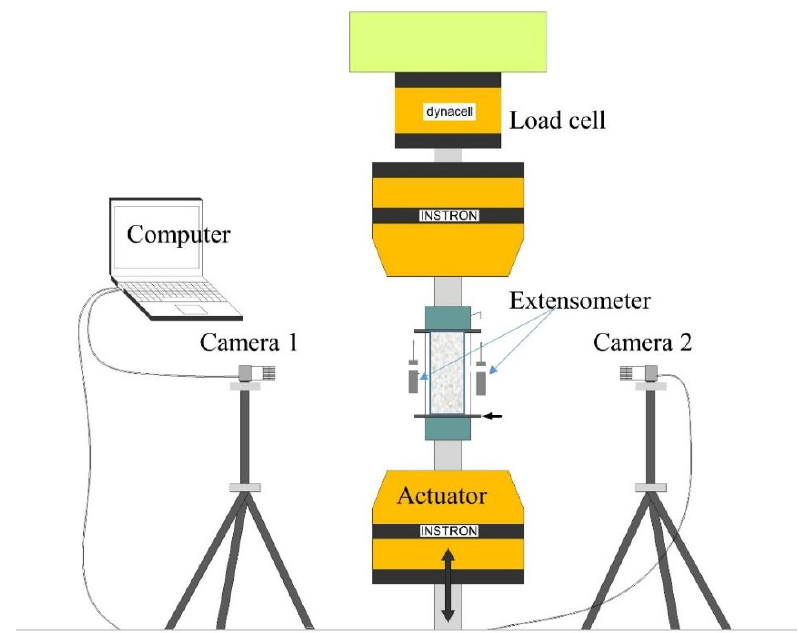
Figure 13. Bending test setup including digital image correlation (DIC) positioning.